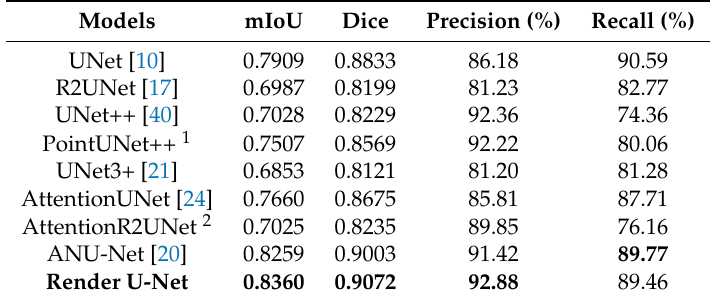
Table 6. Performance of nuclei segmentation by the models in the DSB test dataset.